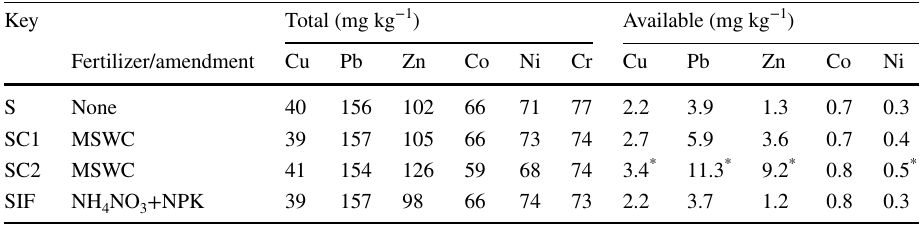
Total Cd and available Cr and Cd concentrations were under the detection limits in all cases. Statistically significant differences ( P < 0.05) with respect to the control are indicated by